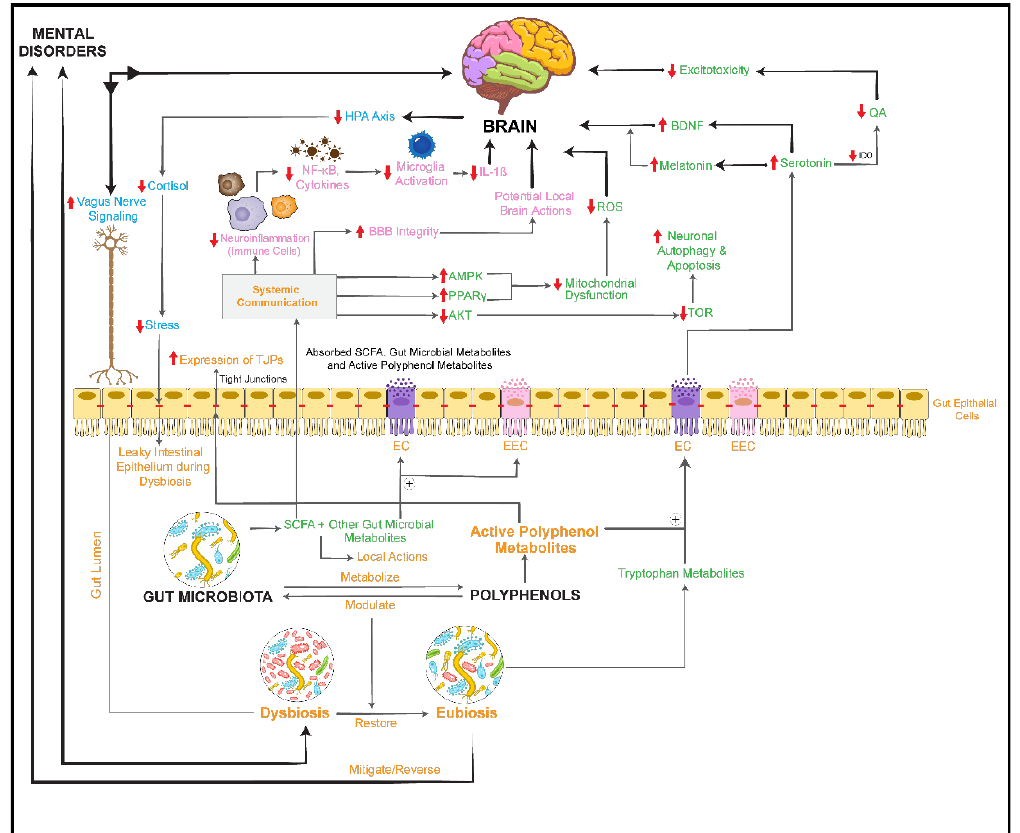
Figure 4. Potential microbiome – gut – brain communication pathways modulated by polyphenols in mental disorders. Gut microorganisms metabolize polyphenols to potentially active metabolites. Polyphenols and their metabolites support the rebalancing of the altered gut microbiome during dysbiosis, and the metabolites can cross the intestinal epithelium and reach the systemic circulation and brain. These molecules may modulate gut – brain communication via neural (blue letters), im- mune (pink letters), and humoral/metabolic (green letters) pathways. Polyphenols and their metab- olites can modulate vagus nerve communication, the HPA axis, pro-inflammatory mediators, neu- rotrophic factors, and serotonin levels, positively influencing brain functions. Polyphenols have an- tioxidant effects and can reduce ROS levels in brain disorders [27,220,250], and they can also stimu- late gut microbiome production of SCFAs [251]. Furthermore, polyphenols and their metabolites may have local brain effects such as improved cerebrovascular blood flow and a reduction in neu- roinflammation [252]. The major gut – brain mechanisms by which polyphenols may exert beneficial effects are indicated with red arrows ( activation/upregulation, inhibition/downregulation). BBB: blood – brain barrier; IDO: indolamine 2,3 dioxygenase; TDO: tryptophan 2,3-dioxygenase; QA: quinolinic acid; PPAR γ : peroxisome proliferator-activated receptor gamma; AMPK: 5′ AMP-acti- vated protein kinase; ROS: reactive oxygen species; TOR: target of rapamycin; : stimulates/pro- motes. 3.3. Herbal Drugs Rich in Polysaccharides Dietary fibers are plant polysaccharides that are indigestible in the upper intestinal tract but that can be metabolized by intestinal microorganisms. These fibers and their mi- crobiota-mediated metabolic end products, i.e., SCFAs, can modulate the gut microbiome composition [37]. Traditional medicines rich in polysaccharides that are used to promote mental health include the rhizomes of Dioscorea opposita (= D. oppositifolia L.; Chinese yam) and the fruits of Lycium barbarum L. (goji). A water – ethanol extract from Chinese yam significantly improved conditions such as fatigue, stress, depression, sleep, and calmness [98], while a standardized juice of L. barbarum fruits was associated with improved cogni- tive function, especially semantic fluency [134].